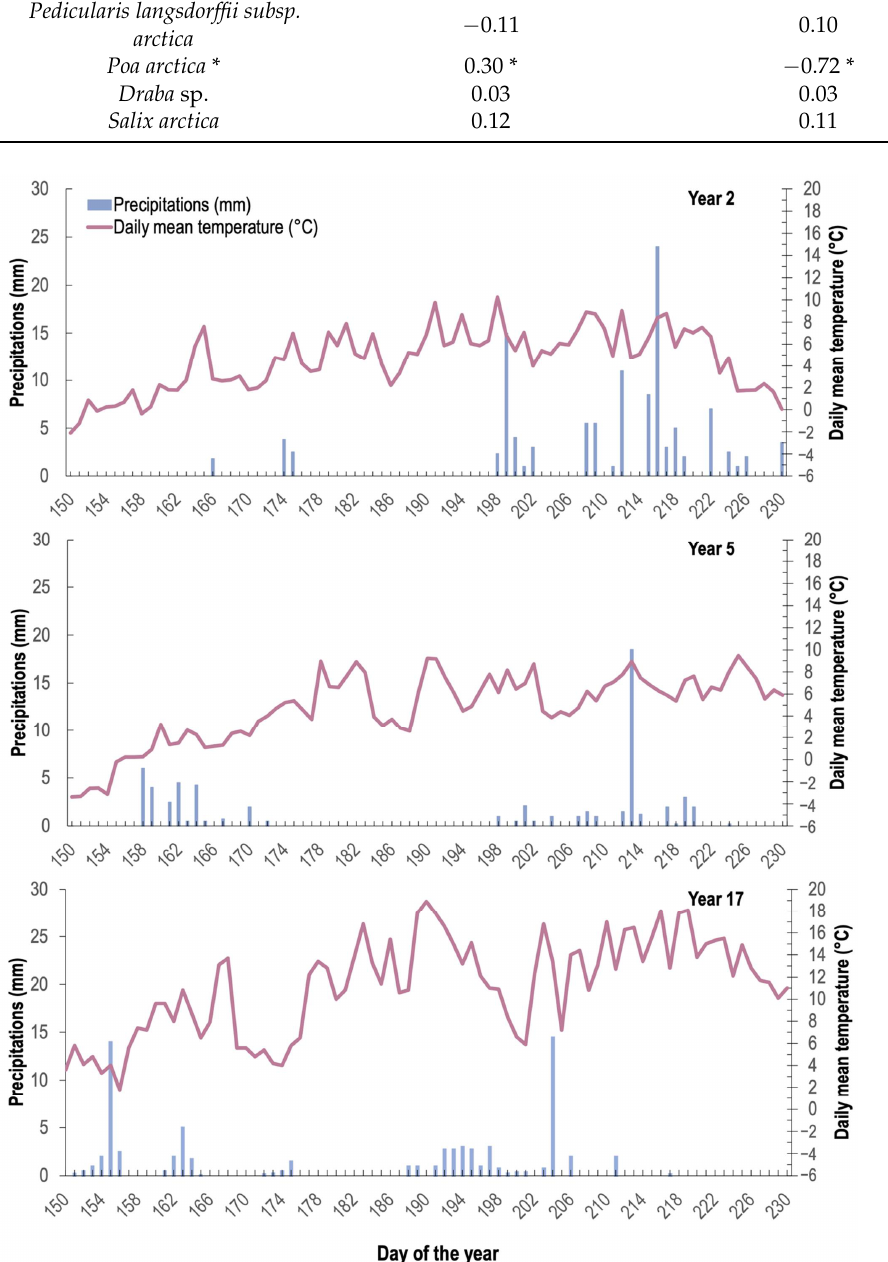
Figure A1. Precipitation (mm) and mean daily temperature (°C) for summer 2004 (Year 2), 2007 (Year 5) and 2019 (Year 16) on Bylot Island. The average daily temperature for the summer was 3.6 °C in 2004, 4.7 °C in 2007 and 11.1 °C in 2019. Cumulative precipitation for the summer was 141.5 mm over 30 rainy days in 2004, 62.7 mm over 26 rainy days in 2007 and 71.8 mm over 32 rainy in 2019 [52] .